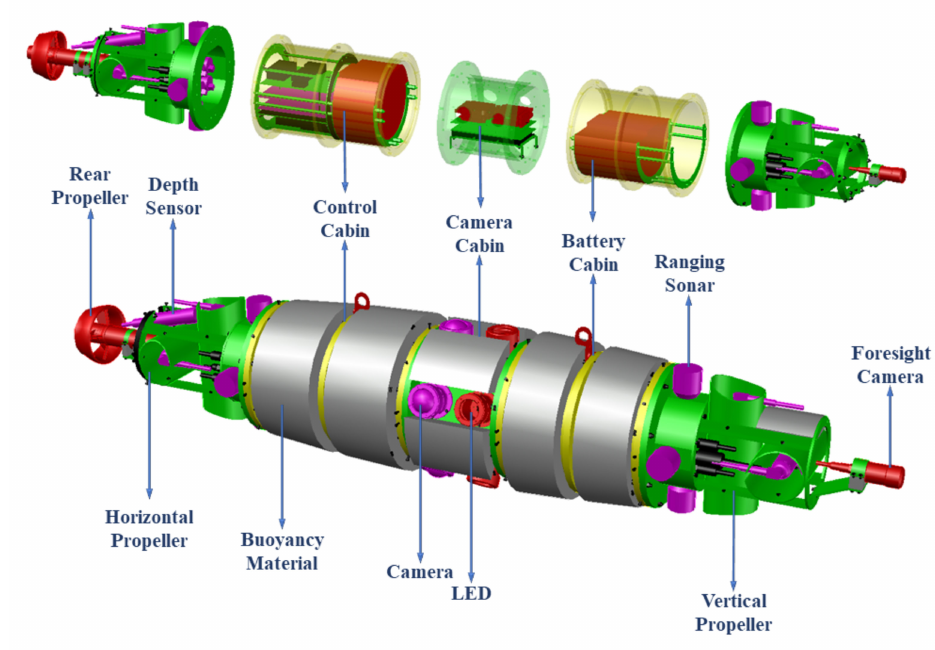
Figure 2. Structure of the